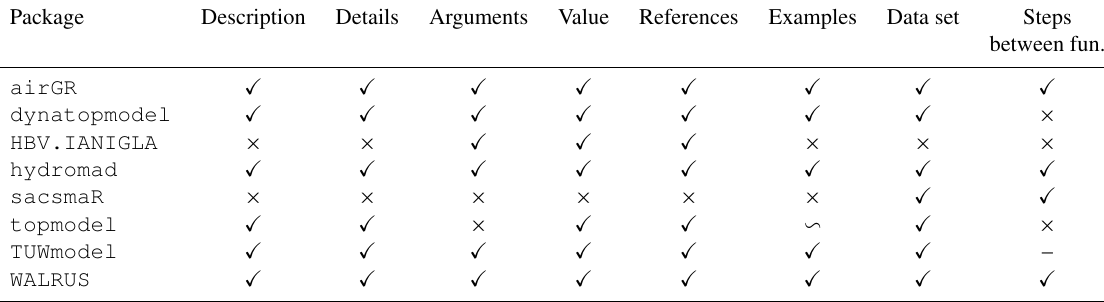
Table 7. Assessment of package documentation. Note: Description – information on the general purpose of the function and the associated possibilities; details – precise explanations of the function; arguments – description of the function arguments that requires details about the unit, the R object class and how to obtain it; value – description of the function outputs; references – related documentation where users can find more information on the function; examples – R commands to use the function (examples are considered as being comprehensive if they cover most of the functionalities and if there is an example for each function); data set – an example data set is provided and can be used with the package functions; steps between functions – explanations of the required stages to run the main functions. The last two fields are not explicit parts of the package manuals but can help one to understand and use a package.